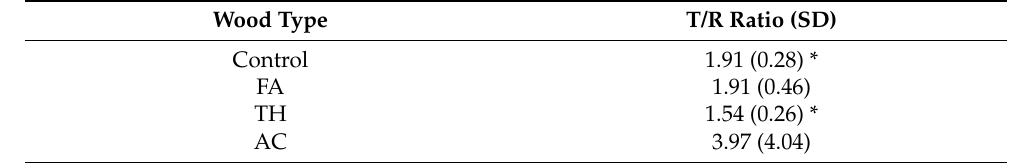
Table 2. Mean swelling anisotropy ratios (T/R) for each wood type, plus standard deviation values (SD) in